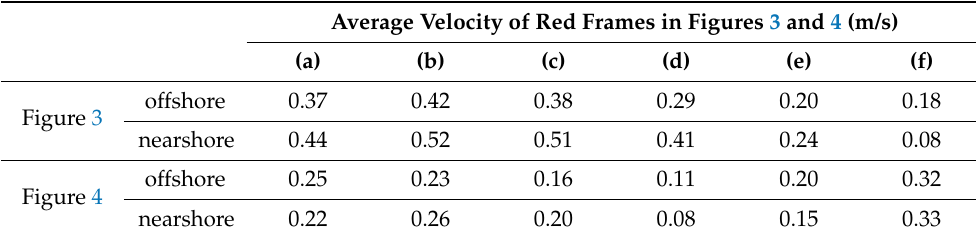
Figure 4. Average flow fields of six-hour periods ( a ) after low tide, ( b ) from one hour after low tide, ( c ) from two hours after low tide, ( d ) from three hours after low tide, ( e ) from four hours after low tide, and ( f ) from five hours after low tide in the summer of 2017. The green square is the tidal station (Linshanbi, located at 25.2839° N, 121.5103° E). The blue arrows represent the averages of flow directions north of Taiwan. Table 1. The average speed of surface current within the red frame of Figures 3 and 4. Average Velocity of Red Frames in Figures 3 and 4